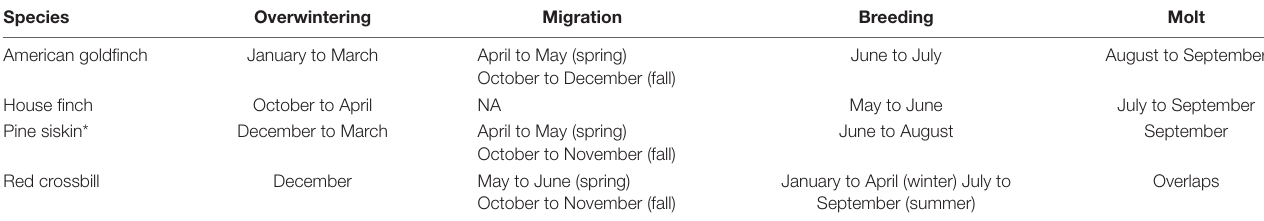
TABLE 2 | Assignment of capture months to the annual schedule for life cycle stage analysis.